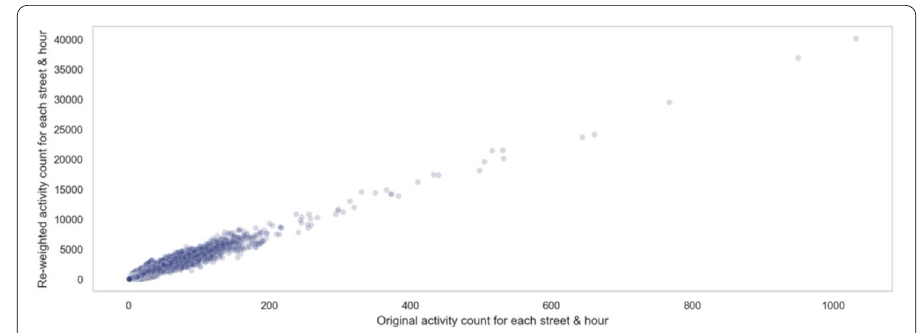
Figure 11 Scatter plot of unweighted and weighted activity count for each street at each